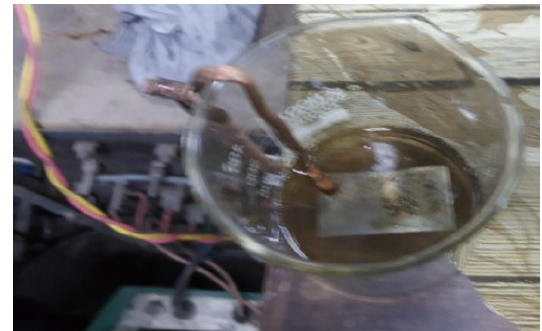
Fig.1: The system of explosion wire in liquid